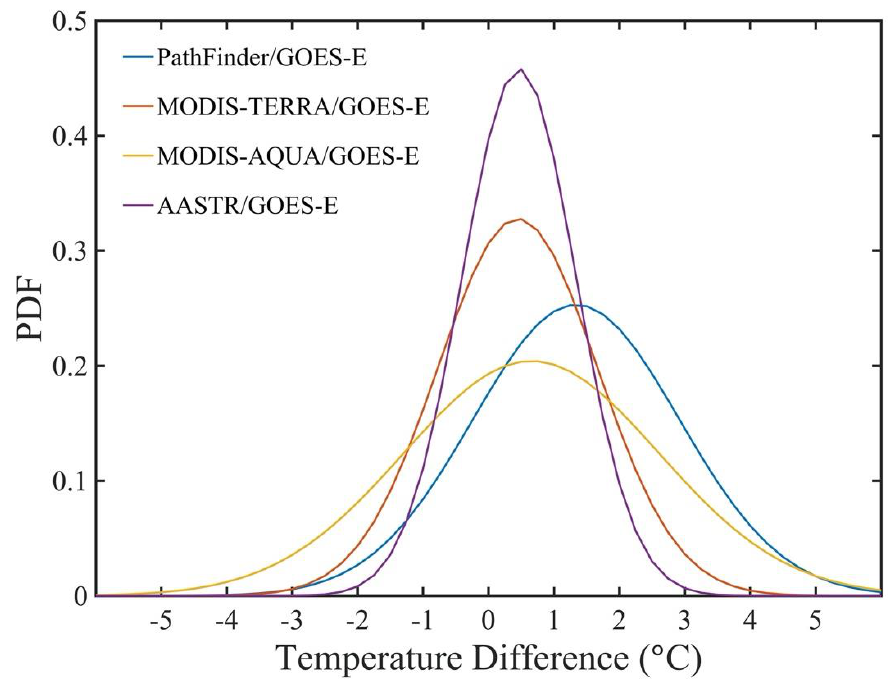
Figure 3. Probability density distribution of the LST differences between MODIS/Aqua, MODIS/Terra, AATSR, AVHRR PathFinder, and GOES-E UMD for the period of 2004–2008. Table 1. Statistics for Figure 3 comparing the differences between GOES-E and all the other JPL products.